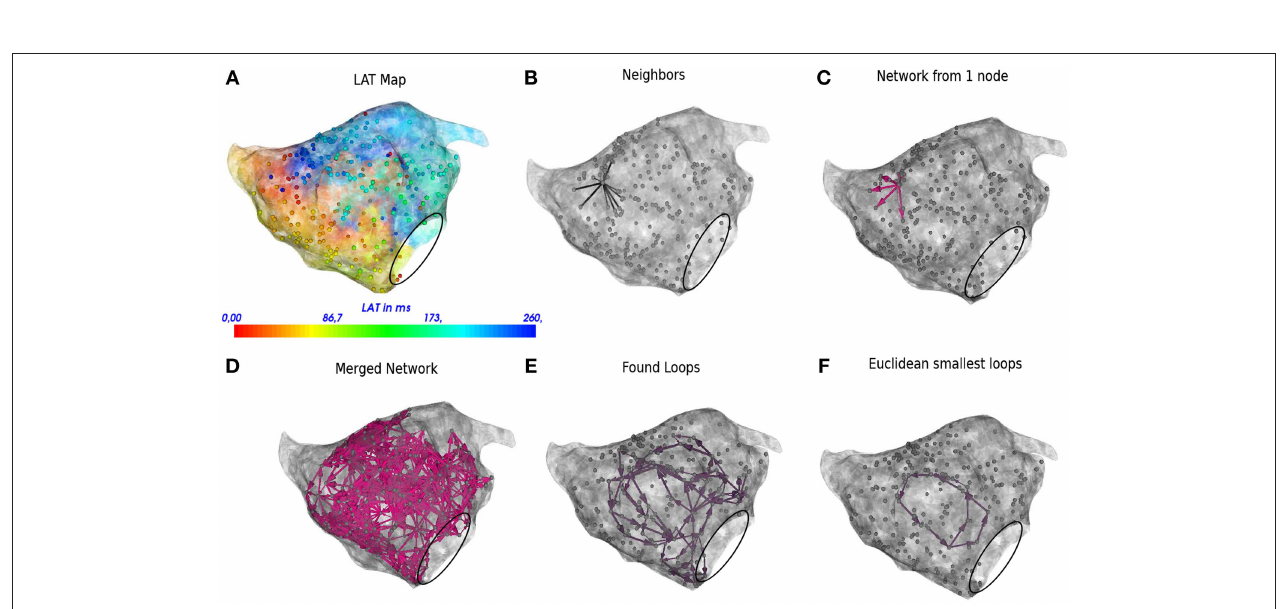
FIGURE 3 | DG mapping for a regular AT case of localized reentry. The gray dots represent the mapping points while the black circle denotes the mitral valve. The LAT annotation map in ms is given in (A) . (B) Shows an example of all possible neighbors for a single annotated location. (C) Represents the corresponding network for the same single annotated location. (D) The complete network is drawn from which all detected loops in the network are derived, see (E) . The loop corresponding to the smallest cycle in the network among the bundle is shown in (F) .